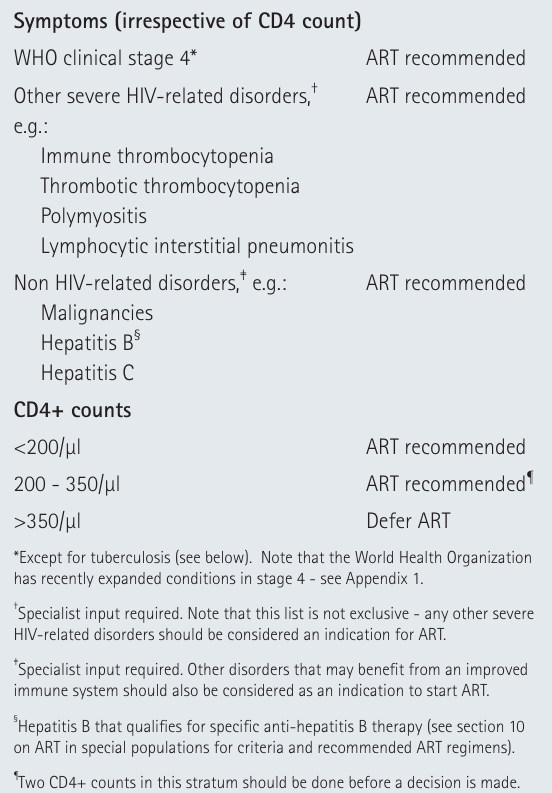
tAble iii. iNdicAtioNs foR ARt (Note thAt